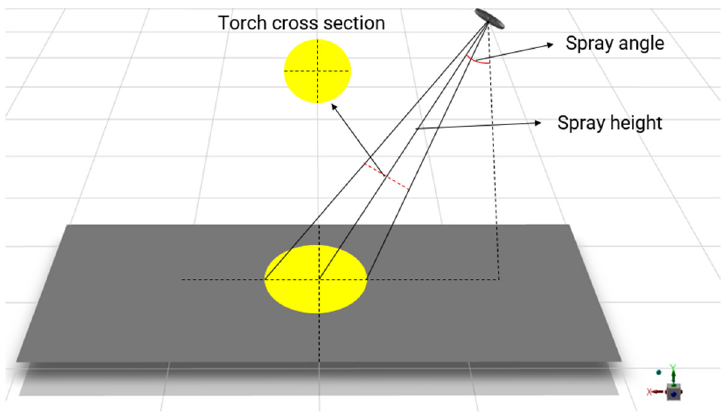
Figure 2. Schematic diagram of the dip-angle spray.